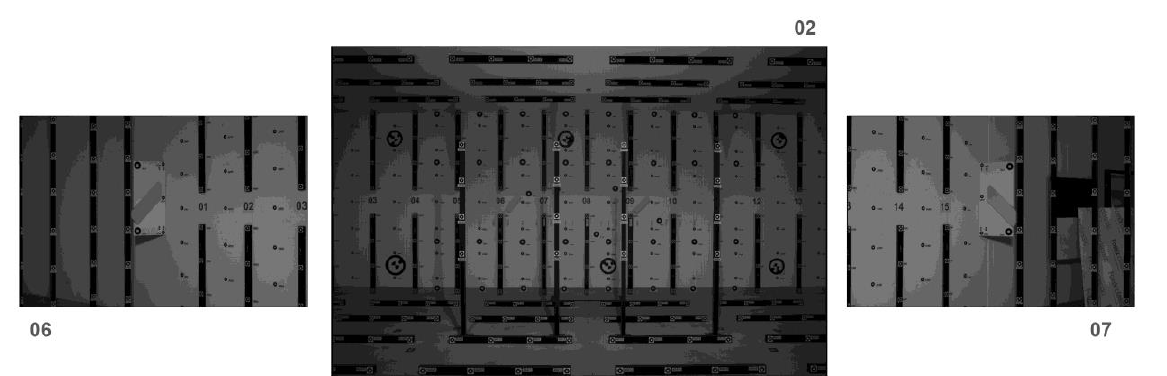
Figure 3: Camera calibration of the UltraCam Osprey. The extended calibration laboratory in Graz, Austria and its 3D Structure is the basis for calibration all camera heads of the UltraCam Osprey (left and right oblique and